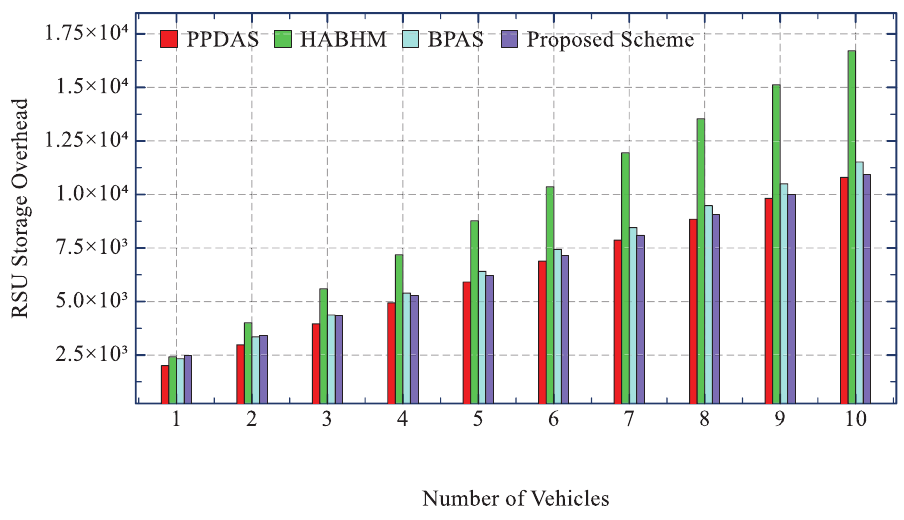
Figure 3. Comparison results on RSU storage